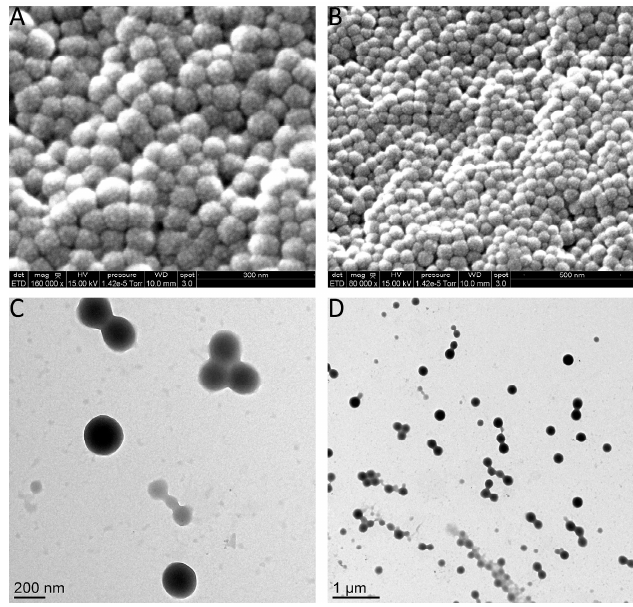
Figure 9. Scanning electron microscopy images of BSA nanoparticles prepared in 10 mM phosphate buffer with ( A ) 2 mL/min injection rate; ( B ) 0.25 mL/min injection rate. Transmission electron microscopy of ( C ) 2 mL/min injection rate; and ( D ) 0.25 mL/min injection rate.